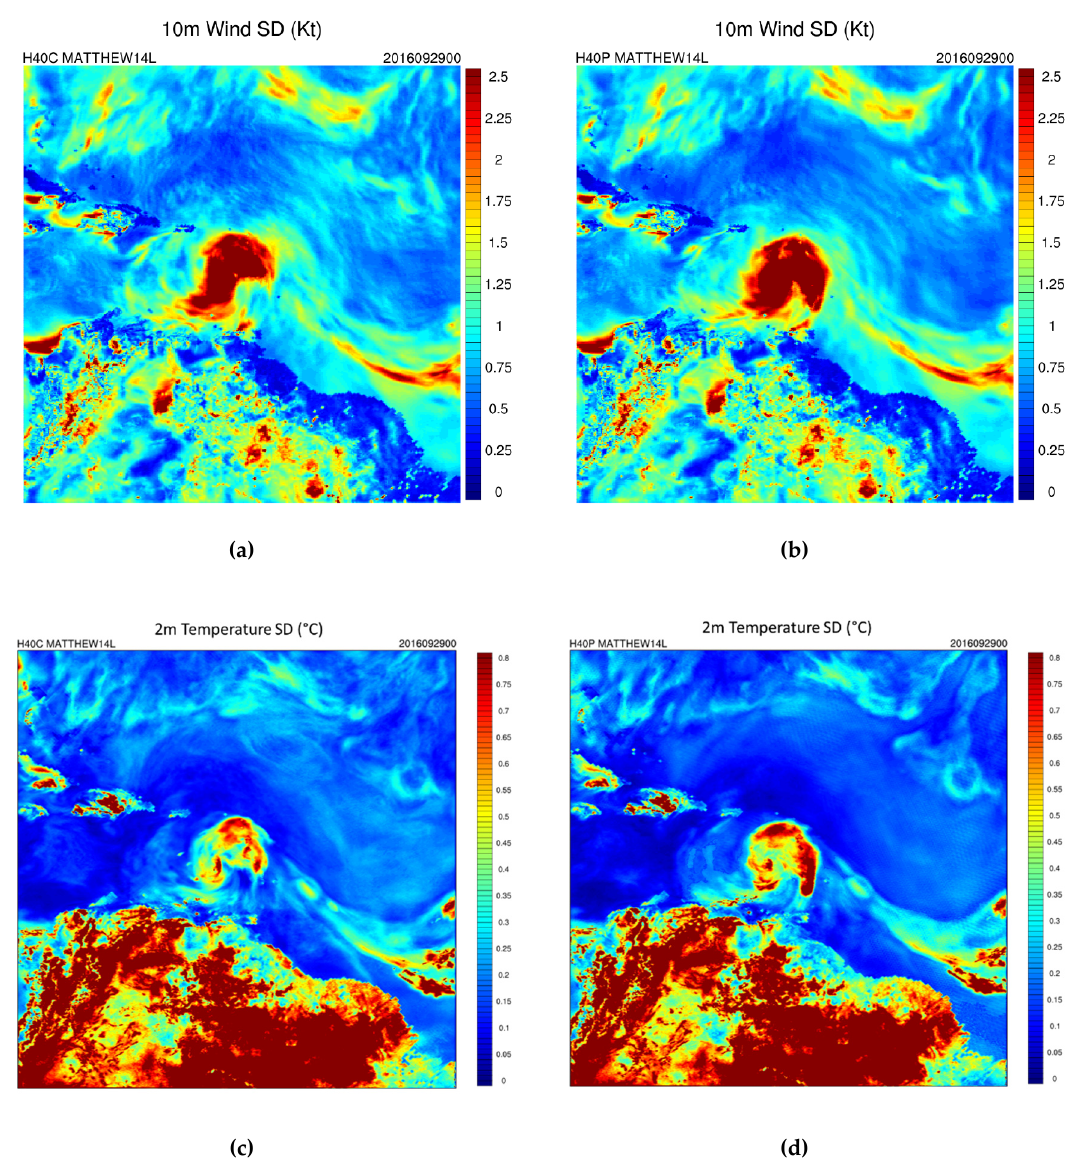
Figure 4. Comparisons of the ensemble spread between H40C ( left ) and H40P ( right ). The 10 m wind speed ensemble spread from H40C ( a ) and H40P ( b ); and the 2 m temperature ensemble spread from H40C ( c ) and H40P ( d ) for Hurricane Matthew, 29 September 2016, 00:00 Universal Time Coordinated (UTC).